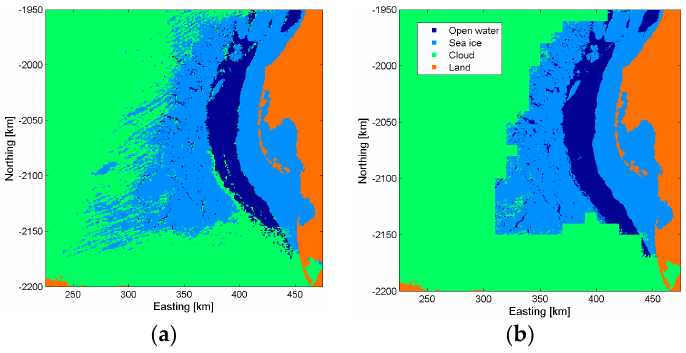
Figure 13. MODIS open water–sea ice classification charts for the images (a) and (c) in Figure 12. ( a )